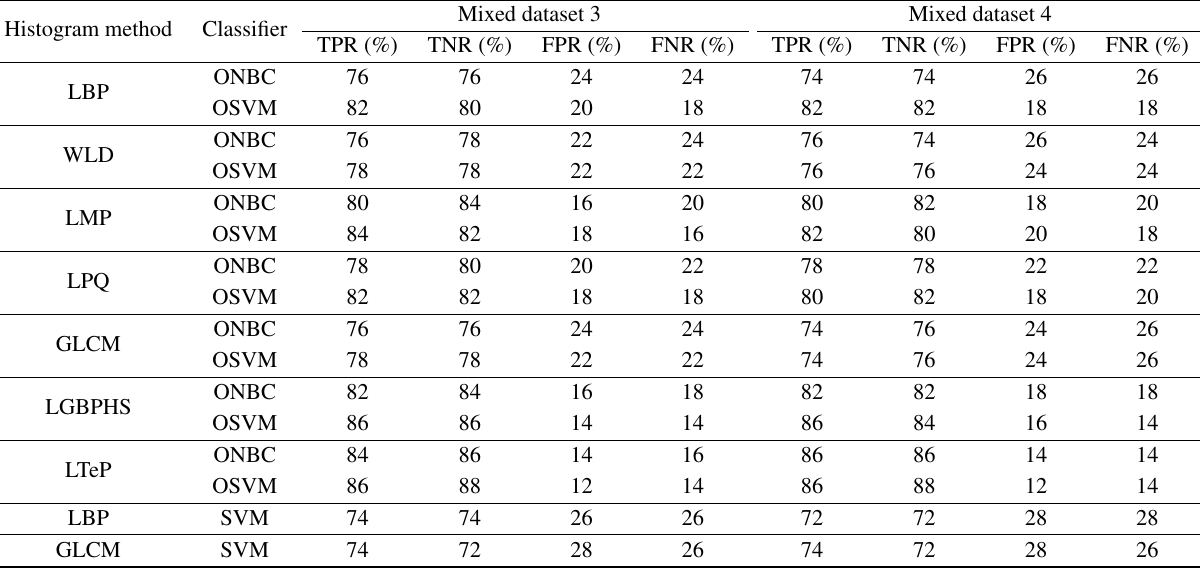
Table 7 Performance of CMFD algorithms with mixed datasets 3 and